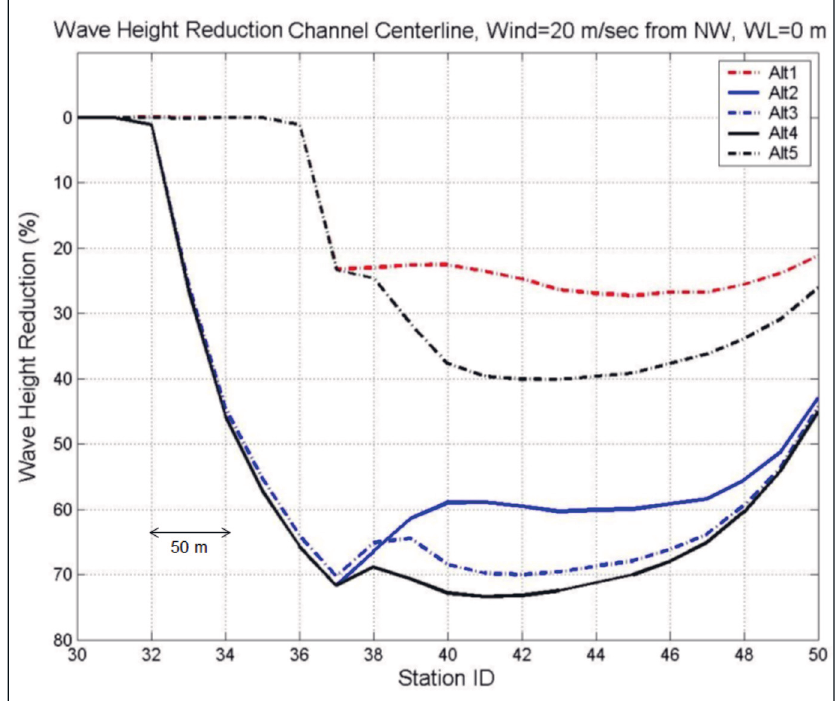
Figure 26. Calculated wave height reduction for Alts 1–5 along the west channel centerline for 50-year design wind from NW and WL = 0